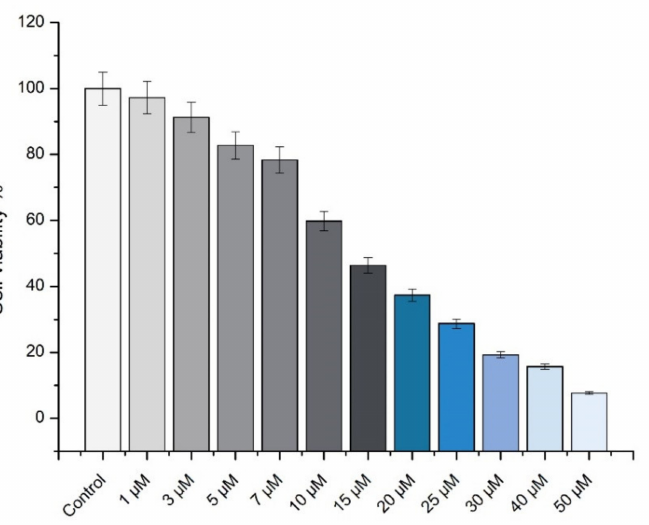
Figure 4. The SIRC cell viability after 24 h exposure with pure 10-HDA solutions. Data represent mean standard deviation (SD), n =